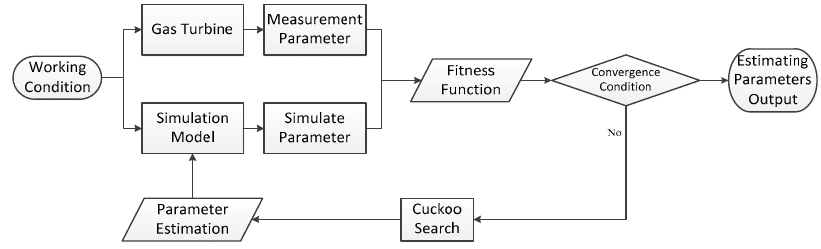
Table 1. Base load parameters of gas turbine.